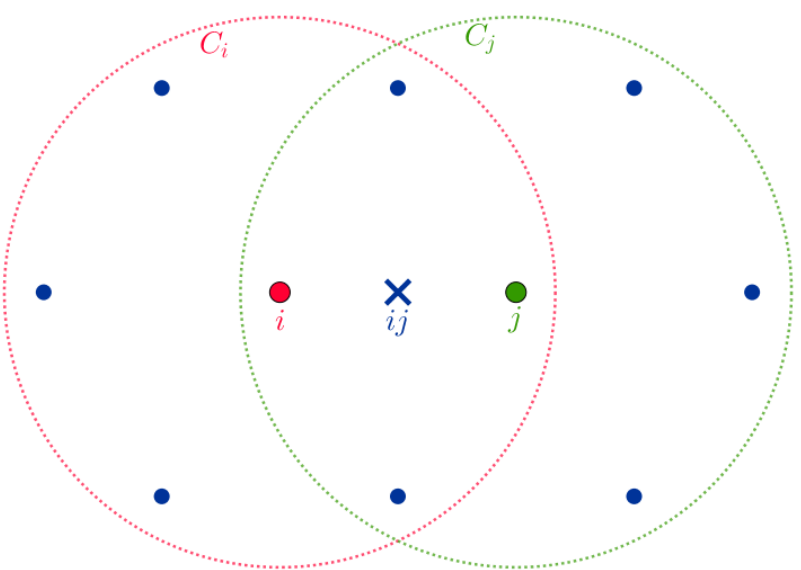
Figure 2. Clouds of computing points surrounding nodes i and j.